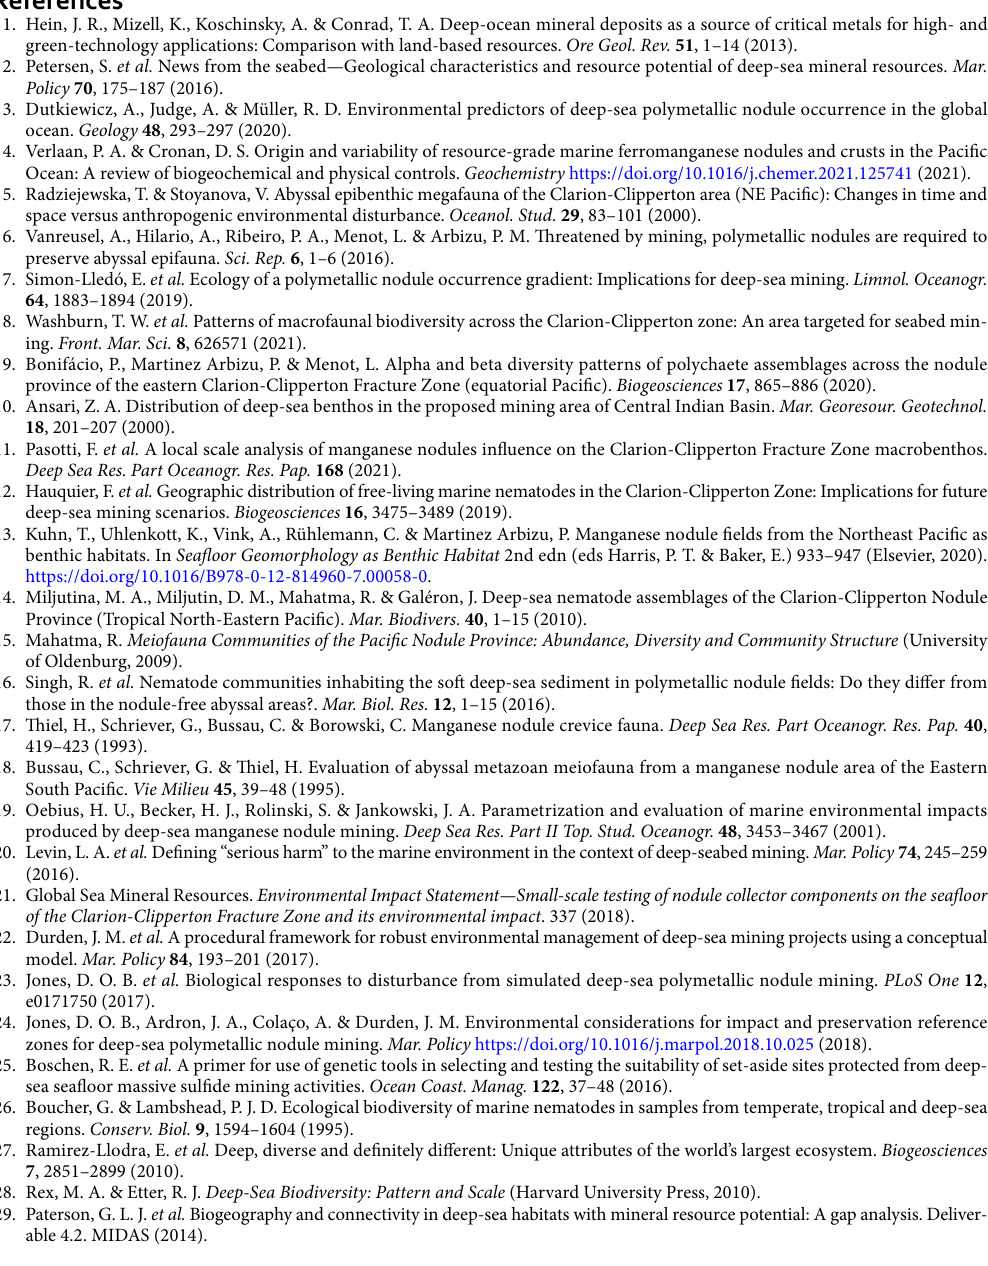
Nodule crevices plus sediments. The contribution of crevice meio- and nematofauna to total meiofauna and nematode diversity was determined for the GSRNOD17 MUC cores by comparing nodule crevice with total (sediment + nodule crevice) diversity (for Hill numbers of orders q = 0, 1 and 2) for the same base sample size in “iNEXT”. Data